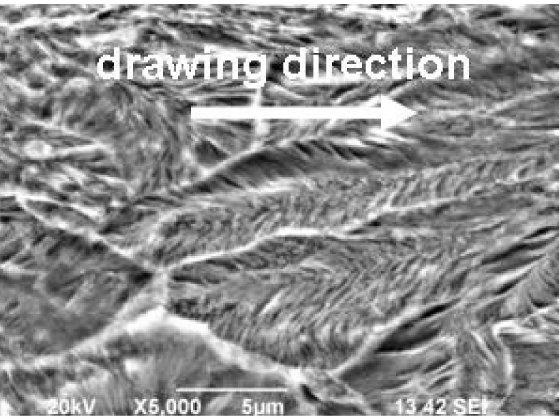
Figure 8. Microstructure of high-carbon steel wire 0.70% C after